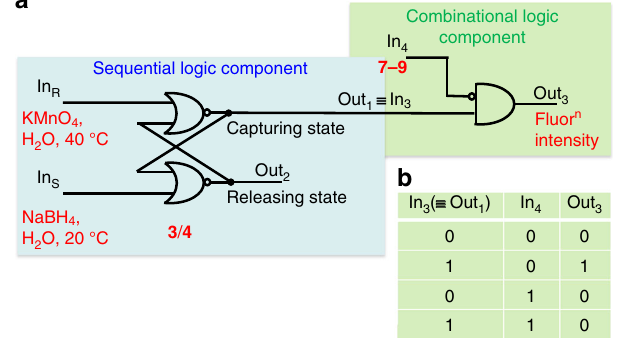
Fig. 3 Integrated sequential-combinational logic. a Physical electronic representation of redox-induced reversible guest release/capture by 3 / 4 in water followed in the latter case by fl uorescence signalling according to INHIBIT logic. Output 1 is the status of the capturing state, which is characterized by the UV spectroscopic parameter ε = 3,900 M − 1 cm − 1 at the absorption maximum wavelength ( λ max ) 290 nm. Output 2 is the status of the releasing state, which is characterized by ε = 31,000 M − 1 cm − 1 at λ fl uorescence max 304 nm. b Truth table for guest ( 7 )-induced quenching of of device 3 / 4 in water corresponding to an INHIBIT logic gate. Guest-free fl uorescence quantum yields ( Φ Flu ) are 0.013 and 0.003 for 4 and 3 , respectively, at pH 10.0, determined by comparison with 2- methoxybenzoate in water at pH 8.0 ( Φ Flu = 0.011) as secondary standard 68 . 7 quenches the fl uorescence of 4 by a factor of 3.1. 7 does not measurably affect the fl uorescence of 3 . The output is digitized by